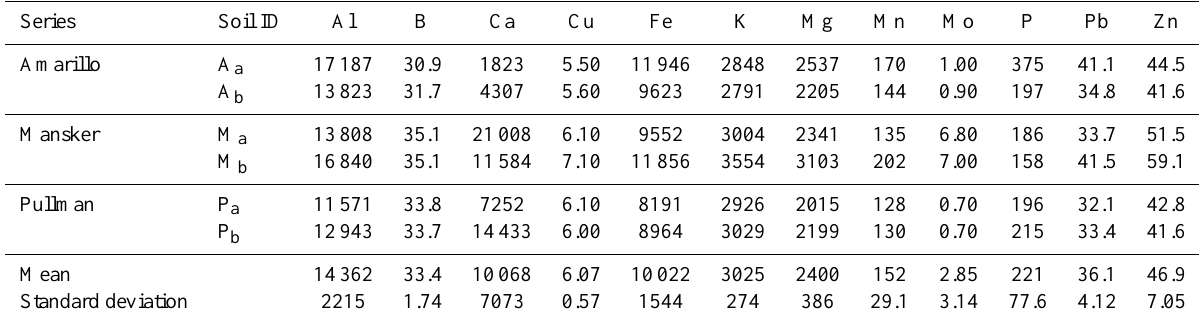
Table 2. Soil total element analysis of the studied semiarid alkaline soils (in mgkg − 1 ) of the Southern High Plains, USA.